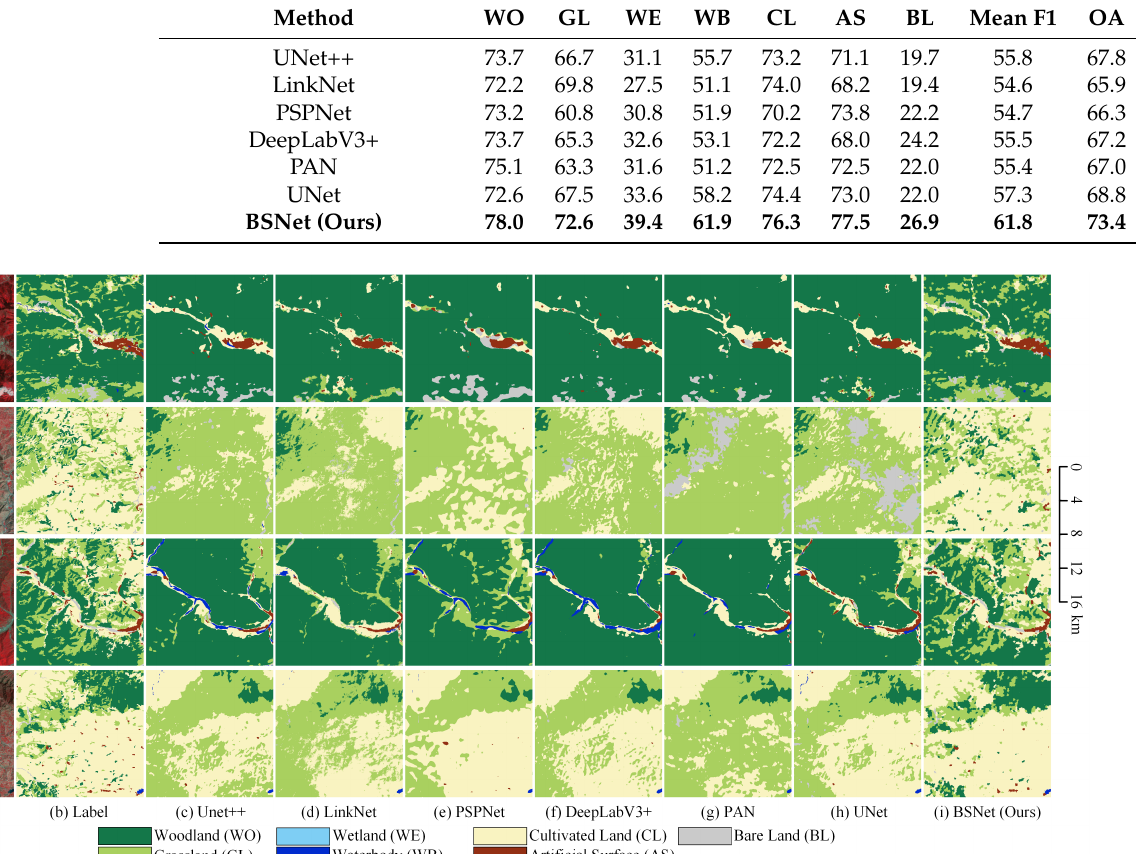
Table 6. Accuracy comparison between our BSNet and other methods on the Landsat supplement dataset.